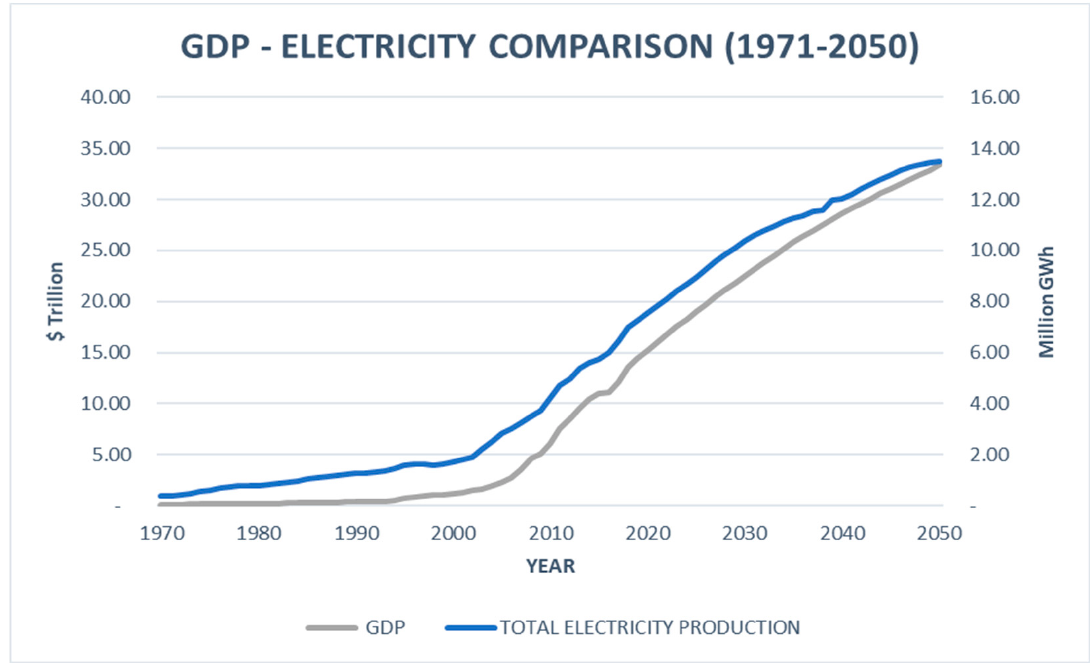
Figure 4. GDP and electricity production from 1971 to 2050 (historical data and forecast) in China.